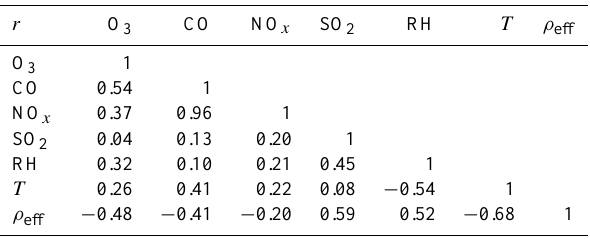
Table 5. Correlation coefficient ( r ) between mid-day (10:00– 13:00LT) mean of ambient particle effective density and other at- mospheric constituents during 7 days of sampling in New Delhi in